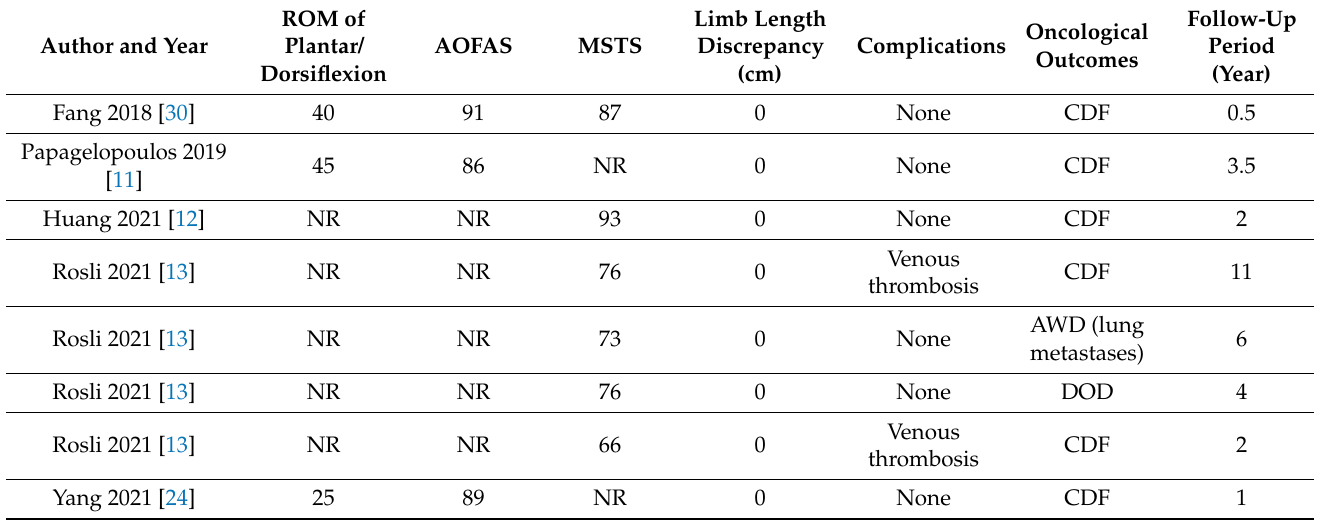
A total of 23 patients who underwent reconstruction after the resection of tumors originating in the talus were included. Of them, 17 (74%) underwent reconstruction with tibiocalcaneal fusion, 1 (4%) with a frozen autograft, and 5 (22%) with a talar prosthesis (Tables 1–3). 2.8. Methodological Quality of Included Studies Evaluation of the quality of the individual studies using the RoBANS tool showed an overall moderate risk of bias. All 20 included studies showed that “selection of partici- pants” and “confounding variables” were high, whereas “measurement of exposure,” “blinding of outcome,” “incomplete outcome data,” and “selective outcome reporting” were low. 3. Results The mean ankle joint ROM in plantar/dorsiflexion in the tibiocalcaneal fusion group was 32.5 (range 30–35) [18,19], while that of the talar prosthesis group was 36.7 (range 25– 45; Table 3) [11,24,30]. The mean AOFAS score in the tibiocalcaneal fusion group was 77 (range 71–83) [25,28], while that of the talar prosthesis group was 89 (range 86–91) [11,24,30]. The AOFAS score was higher in the group reconstructed using a talar prosthe- sis (Table 3). The mean MSTS score in the tibiocalcaneal fusion group was 77.6 (range 66– 90) [7,9,13,25], that in the frozen autograft group was 70 [8], and that in the talar prosthesis